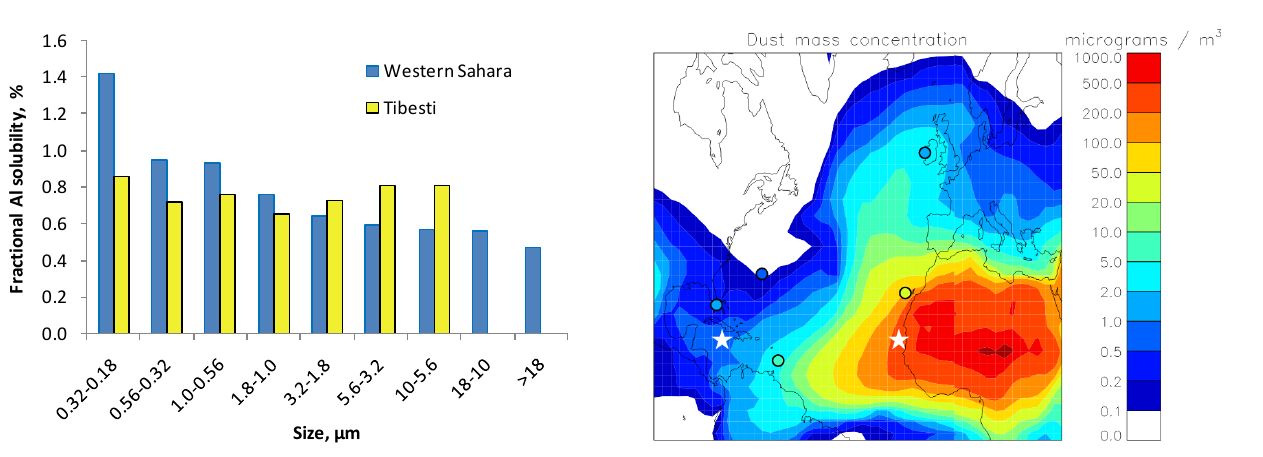
Fig. 3 Fractional Al solubility (FS-Al) of size-fractionated dust generated from Fig. 3. Fractional Al solubility (FS-Al) of size-fractionated dust Western Sahara and Tibesti samples generated from Western Sahara and Tibesti samples.